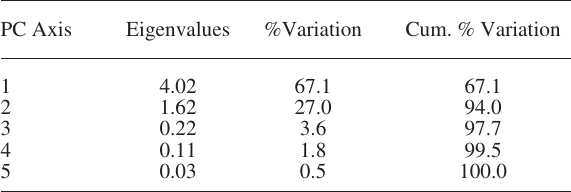
Table 3. – Results of the Principal Component Analysis.